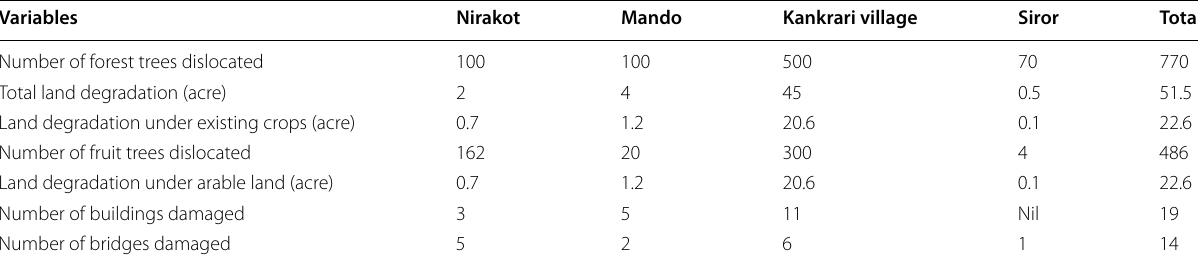
Table 3 Environmental impact of cloudburst-triggered debris flow and flash flood. Source : by authors Variables Nirakot Mando Kankrari village Siror Total Number of forest trees dislocated 100 100